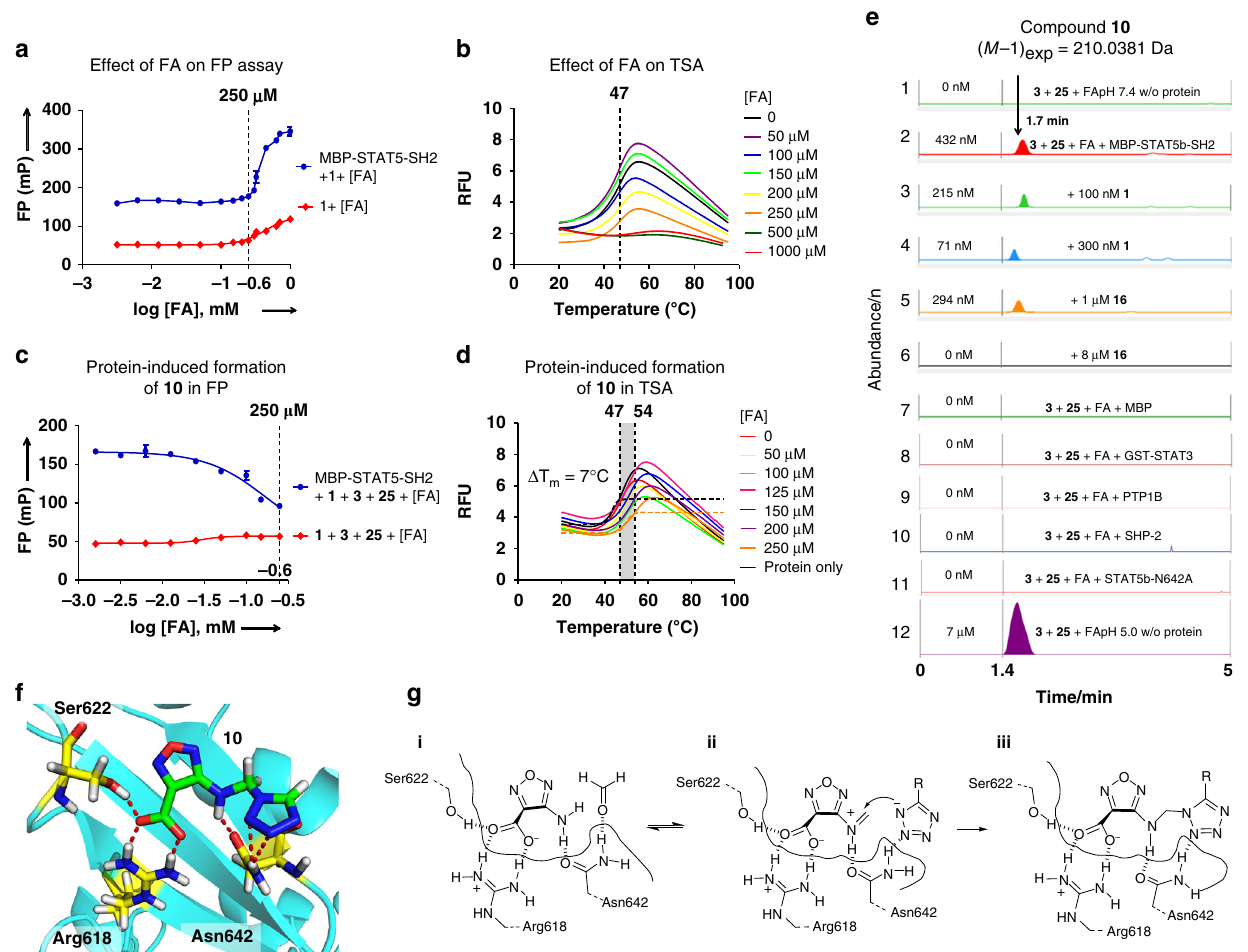
Fig. 3 Assembly of STAT5 inhibitor 10 through protein-induced Mannich ligations. a FA was tolerated at up to 250 µ M in the FP assay of MBP-STAT5b-SH2 ( n = 3). b FA did not affect the STAT5b protein stability in the TSA at ≤ 250 µ M (data shown are one representative of n = 3). c Protein-induced formation of 10 in the FP assay with increasing FA concentrations ( n = 3). d Protein-induced formation of 10 from fragments 3 and 1 H -tetrazole 25 with increasing FA concentrations in the TSA ( Δ T m = 7 °C) (data shown are one representative of n = 3). e Formation of 10 detected in the HPLC-QTOF-MS. 1: No formation of 10 from FA, fragments 3 and 25 (all 250 µ M ) at pH 7.4 in MOPS buffer without protein. 2: Protein-induced formation of compound 10 with protein MBP- STAT5b-SH2 (250 n M ) at pH 7.4. 3 – 6: Inhibition of protein-induced formation of 10 by peptide 1 (3,4) or inhibitor 16 (5,6). 7,8: No formation of compound 10 in the presence of Maltose Binding Protein (1 µ M ) or GST-STAT3 (250 n M ). 9 – 11: Compound 10 was not formed in the presence of phosphatases, SHP2 (250 n M ) and PTP1B (250 n M ) nor in the presence of mutant STAT5b-N642A at pH 7.4 in MOPS buffer. 12: Formation of compound 10 at pH 5.0 without protein. Data shown are one representative example of n = 3. f 3D-binding model of the STAT5b: 10 complex. Hydrogen bonds are illustrated as red dashed lines. g , Mechanism of the protein-induced formation of 10 from 3 with FA and 25 (R = H). ( i ) Binding of 3 via Arg618, Ser622, and Asn642, activation of FA with Asn642. ( ii ) Activation of the forminium cation of 3 , coordination of the incoming tetrazolium anion of 25 by Asn642 leads to formation of Mannich ligation product 10 ( iii ). Error bars denote mean ±